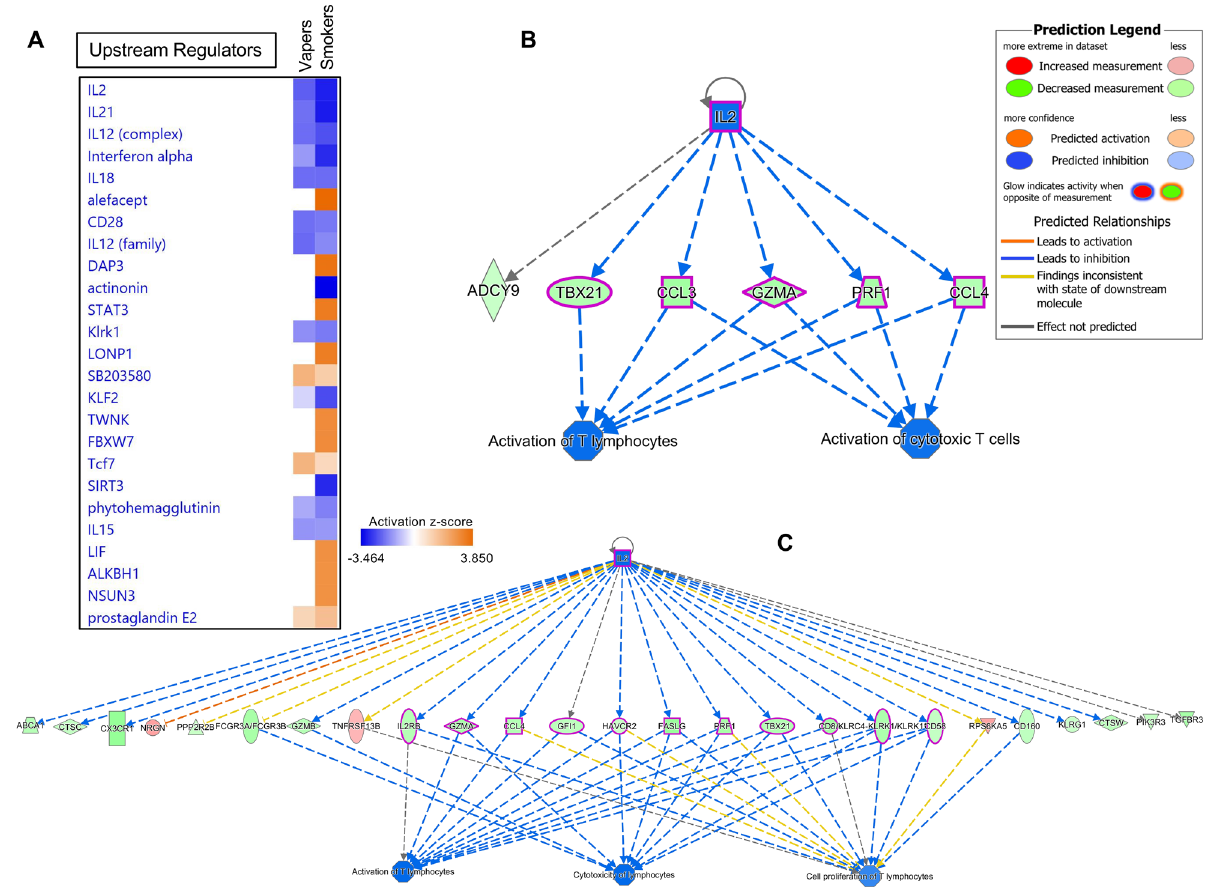
Figure 6. Upstream Regulator Analysis of differentially expressed genes in vapers and smokers. The IPA Upstream Regulator Analysis was used to identify upstream regulators that are likely to account for the aberrant expression of genes identified in vapers and smokers. (A) The Upstream Regulator Heat Map for the top 25 upstream regulators is shown. Orange squares indicate predicted increase in regulator’s activity, whereas blue squares indicate predicted decrease in activity. Of interest, the most significant upstream regulators identified in both vapers and smokers are members of a large class of proteins known as cytokines (IL2, IL21, IL12, IFNα, IL18, etc.), which play a crucial role in innate immunity and inflammation. Based on the activation z -score, all cytokines in the list are predicted to be inhibited in both vapers and smokers, although the number of affected downstream molecules differs between the two groups. (B) Regulatory network of IL2, its targeted genes and downstream biological effects in vapers. In vapers, inhibition of IL2 is likely to lead to downregulation (indicated by blue lines) of genes (shown by green color), which in turn may lead to impaired immune response ( i.e. , lack of activation of T lymphocytes). (C) Regulatory network of IL2, its targeted genes and downstream biological effects in smokers. Likewise, in smokers, inhibition of IL2 is likely to disrupt normal immune functions, though the number of genes modulated by IL2 is much higher in smokers than vapers (25 vs . 6). For more indicators, please refer to the Prediction